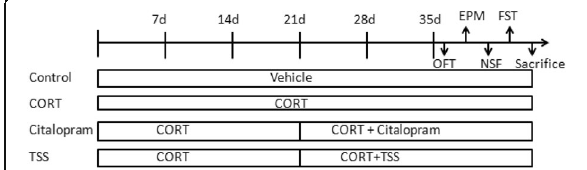
Fig. 1 The schematic representation of experiment 2 design. Male C57BL/6 J mice were divided 4 groups: Control, CORT, Citalopram (10 mg/kg) and TSS (25 mg/kg). Vehicle and corticosterone were delivered for 5 weeks and continued through the behavior testing period. After 3 weeks of drug-free exposure to CORT administration, TSS and citalopram were given intragastrically once a day for 2 weeks and continued through the behavior testing period. OFT, EPM, NSFT and FST were performed. After behavior tests, the mice